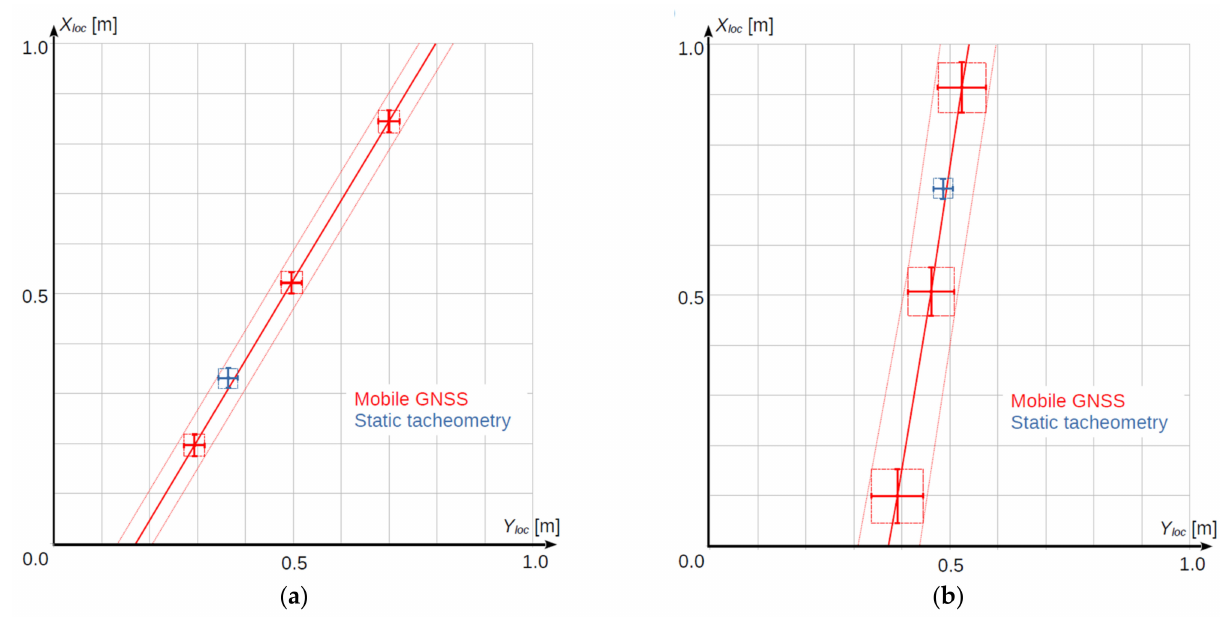
Figure 15. Comparing the results obtained from GNSS system and from static method: ( a ) good conditions, ( b ) unfavorable